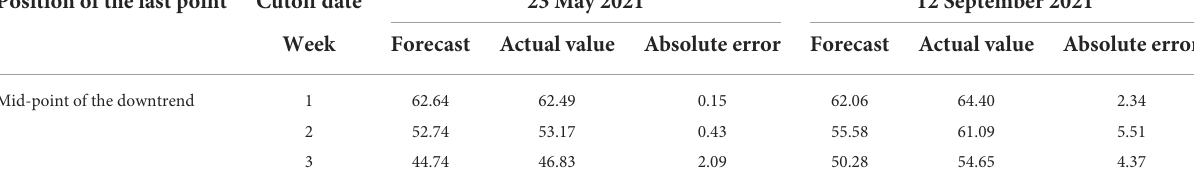
TABLE 6 Forecast result when the last point is at the midpoint of the downward trend. Position of the last point